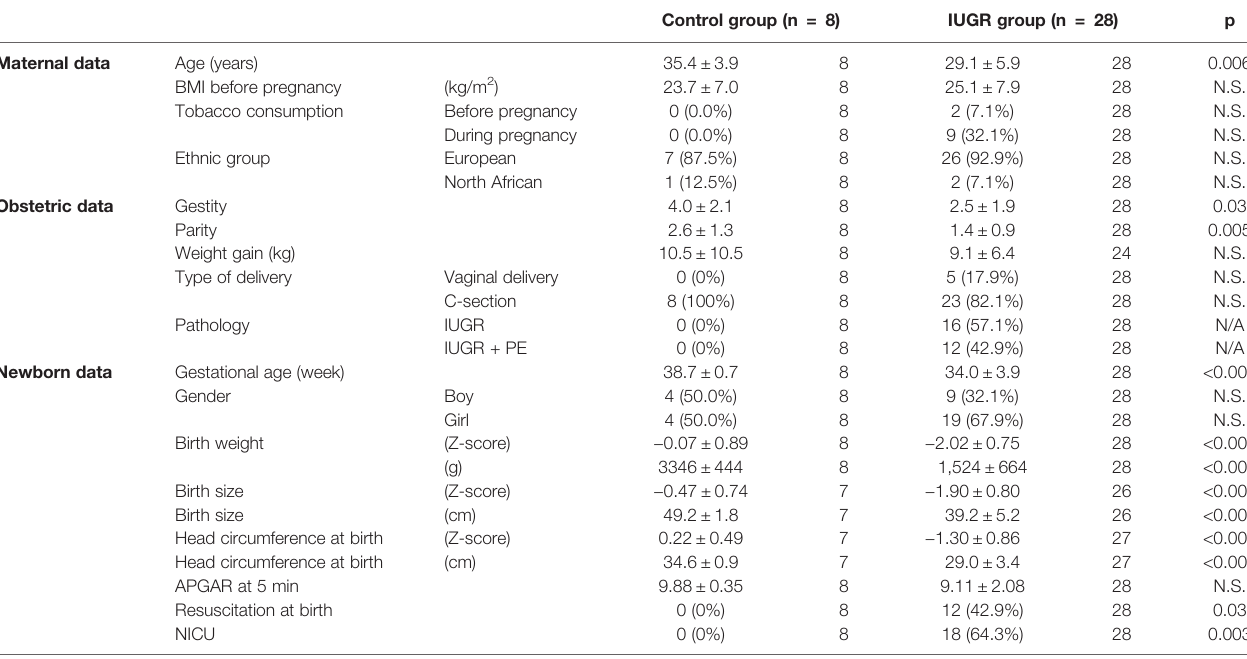
TABLE 1 | Description of the patient cohort. p -values were computed using Wilcoxon tests (quantitative values) or Fisher tests